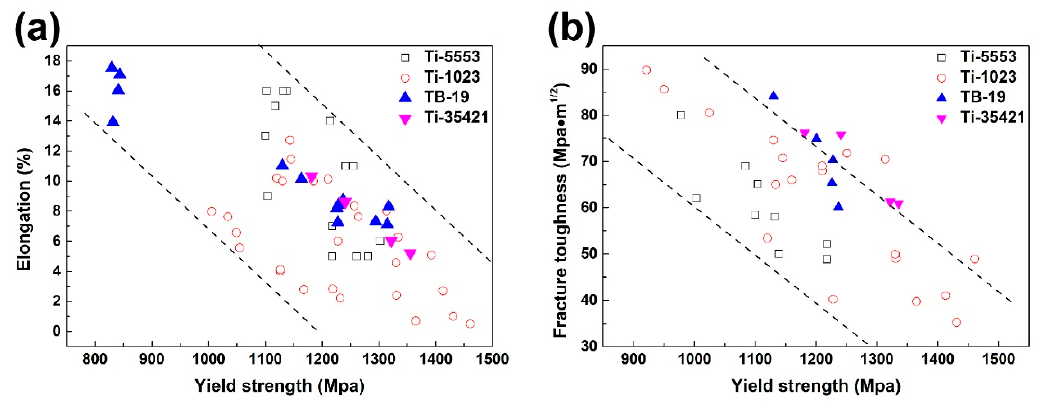
Figure 11. Performance comparison between Ti-35421, Ti-B19, Ti-5553, and Ti-1023: ( a ) yield strength vs. elongation, ( b ) yield strength vs. fracture toughness. (Ti-B19 [29], Ti-5553 [30,31], Ti-1023 [19,32]).